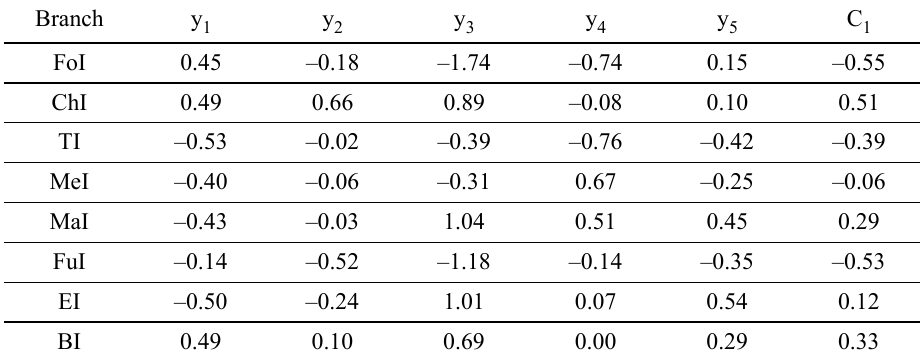
Table 3. Average component scores for individual